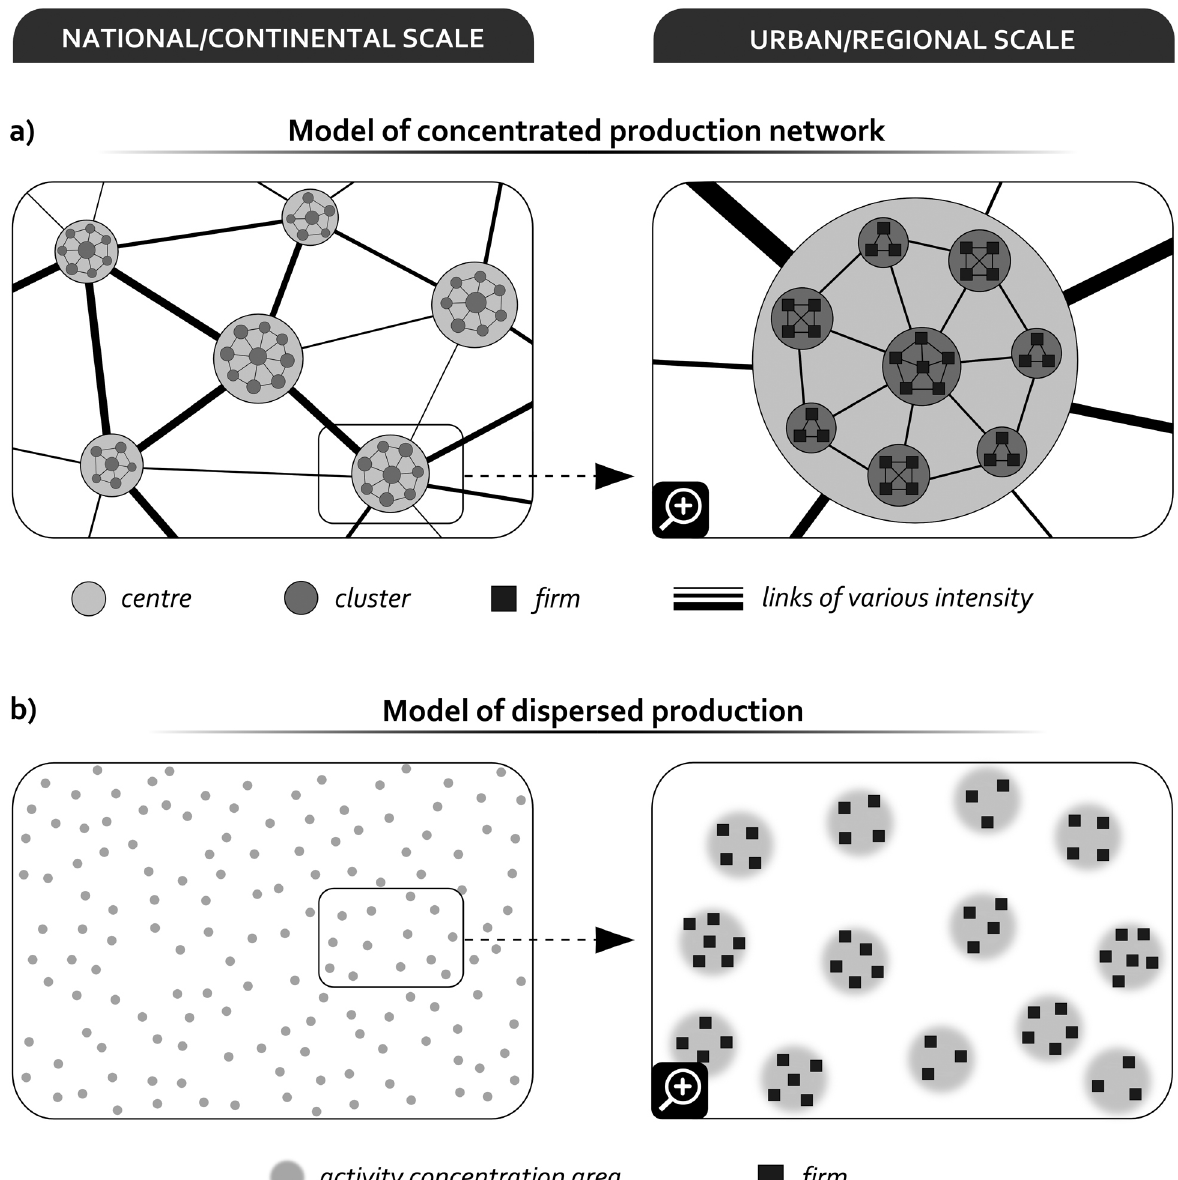
Fig. 4. Location models of creative industries: a) the model of a concentrated production network; b) the model of dispersed production. Source: own